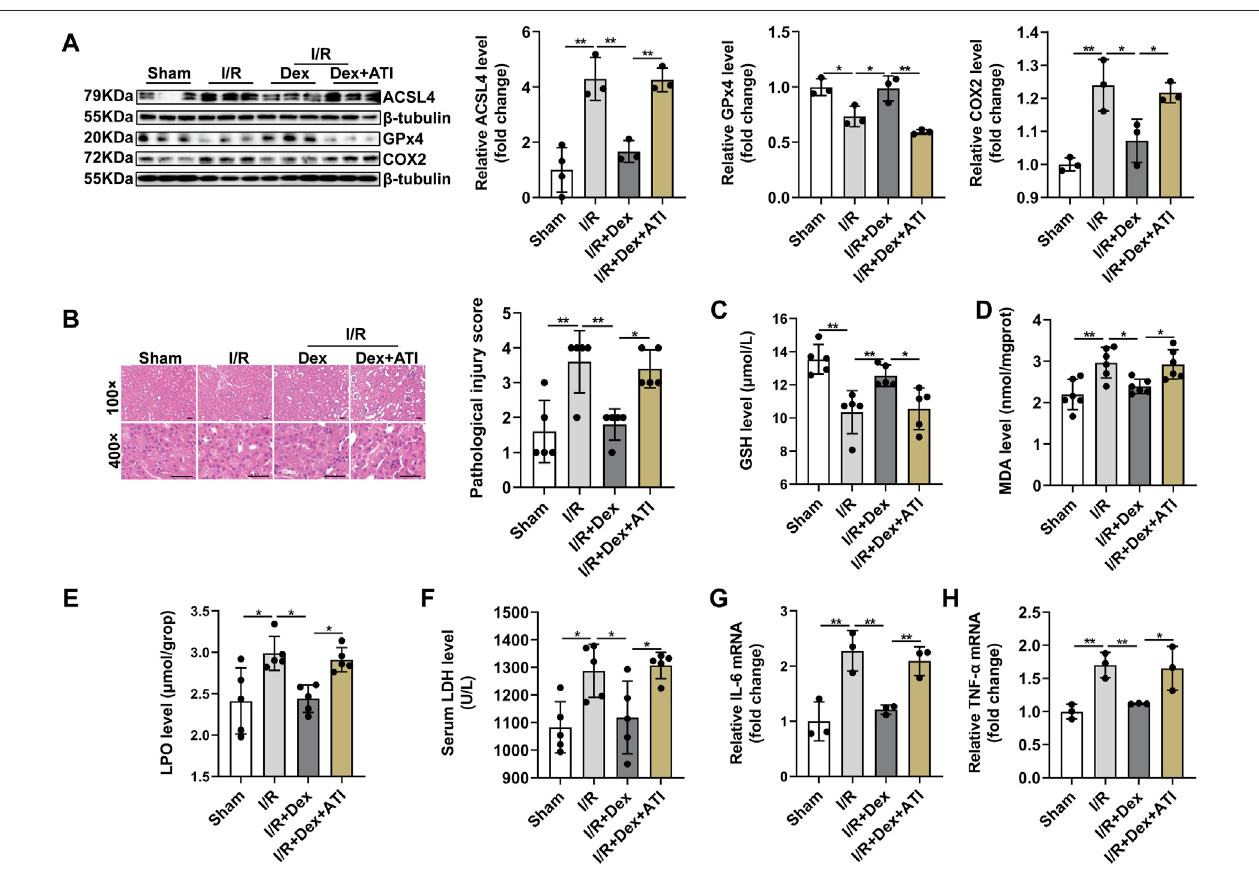
FIGURE 6 | Dexmedetomidine alleviates ferroptosis-induced I/R injury and in fl ammation through targeting ACSL4 via α 2-AR. (A) Validation of ACSL4, GPx4 and COX2proteinexpressionbywesternblotanalysis( n =6). (B) RepresentativeH&Estaining(originalmagni fi cation,×100or×400,Scalebar=20 μ m)andcorresponding relative renal injury score were shown ( n = 5). (C – E) GSH ( n = 5), MDA ( n = 6), LPO ( n = 5) levels in renal homogenates ( n = 5). (F) Serum LDH was measured from each group ( n = 5). (G,H) Validation of IL-6 mRNA and TNF- α mRNA expression by qRT-PCR analysis ( n = 5). The data are the Means ± S.D., * p < 0.05, ** p <